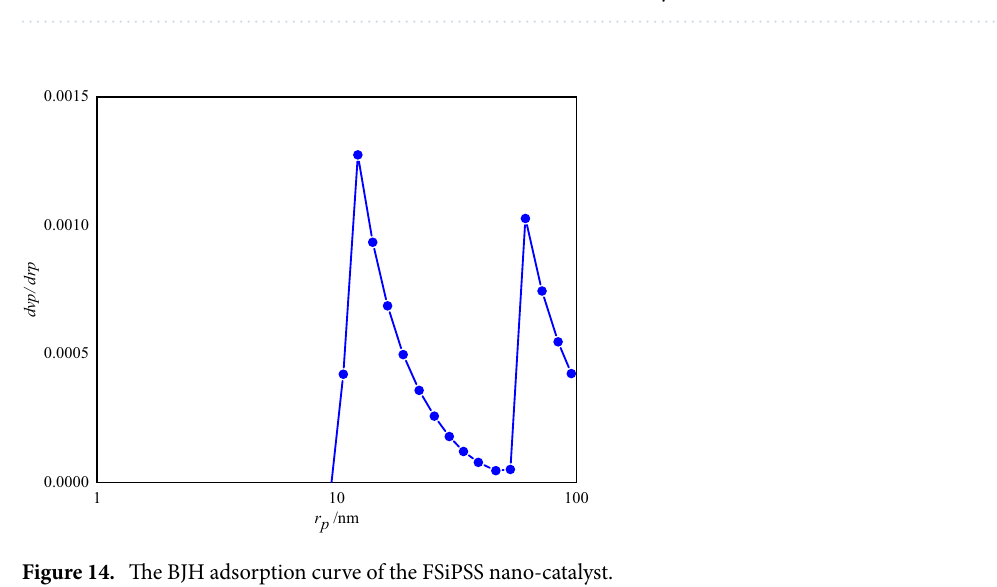
Figure 14. The BJH adsorption curve of the FSiPSS